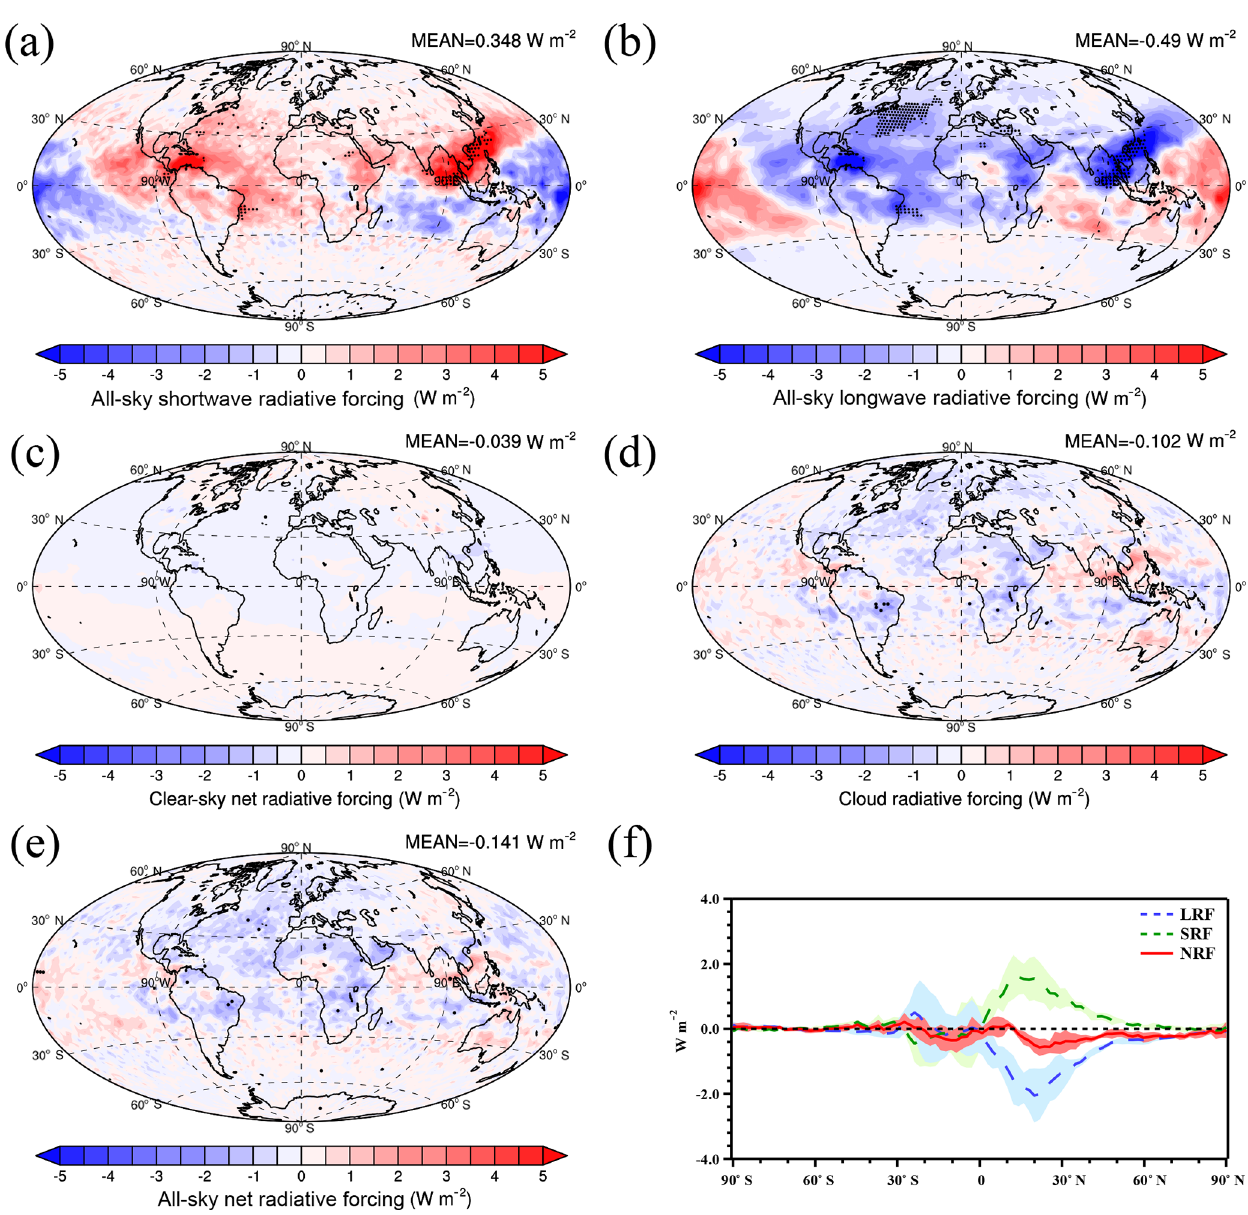
Figure 7. Annual mean plots of all-sky shortwave radiative forcing (a) , all-sky longwave radiative forcing (b) , clear-sky net radiative forc- ing (c) , cloud radiative forcing (d) , and all-sky net radiative forcing (e) as well as all-sky longwave radiative forcing ( f , LRF, blue dashed line), all-sky shortwave radiative forcing ( f , SRF, green dashed line), and all-sky net radiative forcing ( f , NRF, red solid line) versus latitude for the difference between the PD_Base and PI_cSoot cases. Differences significant at the 90% level according to a Student’s t test are depicted by points. The shading in (f) represents 1 standard deviation of the interannual variation over 6